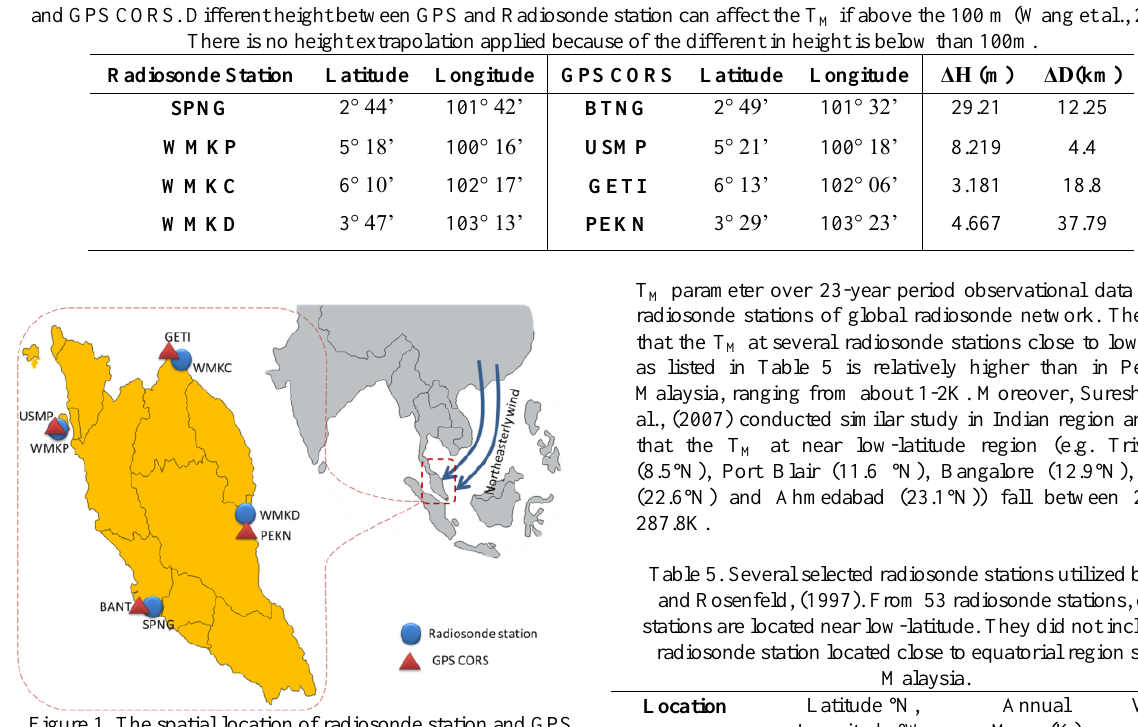
Table 2. The coordinates of radiosonde stations and GPS CORS, and the different height and distance between radiosonde station and GPS CORS. Different height between GPS and Radiosonde station can affect the T M if above the 100 m (Wang et al., 2005). There is no height extrapolation applied because of the different in height is below than 100m.